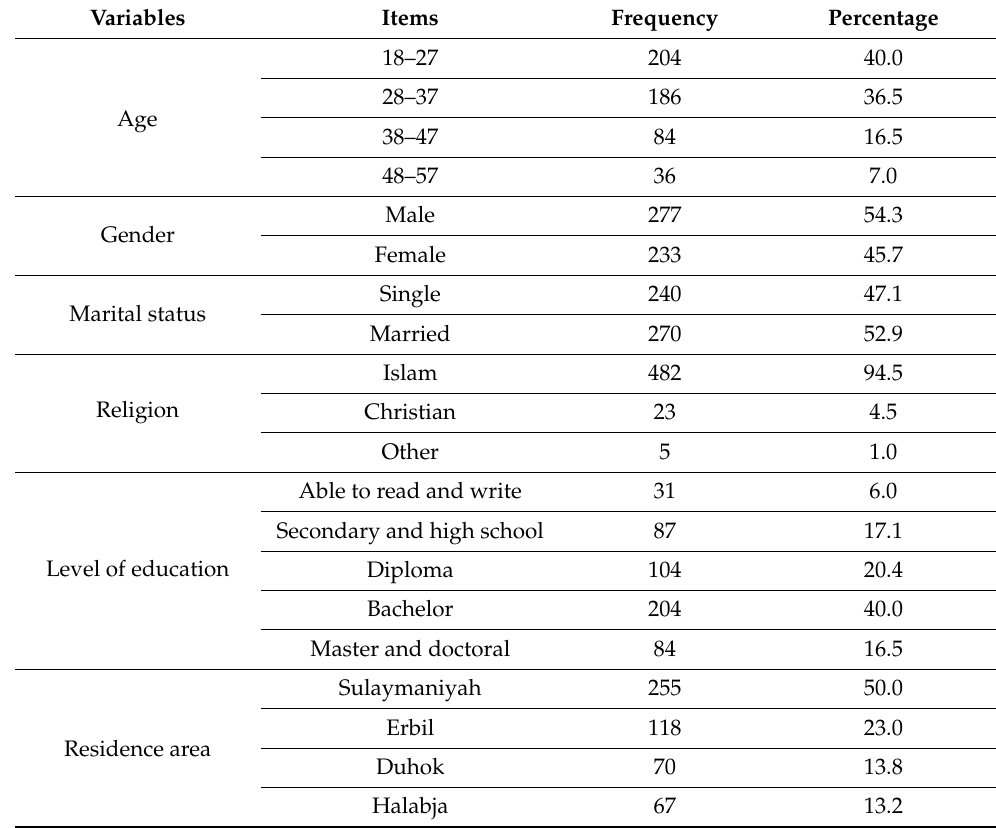
Table 1. Sociodemographic characteristics of the study sample ( n =